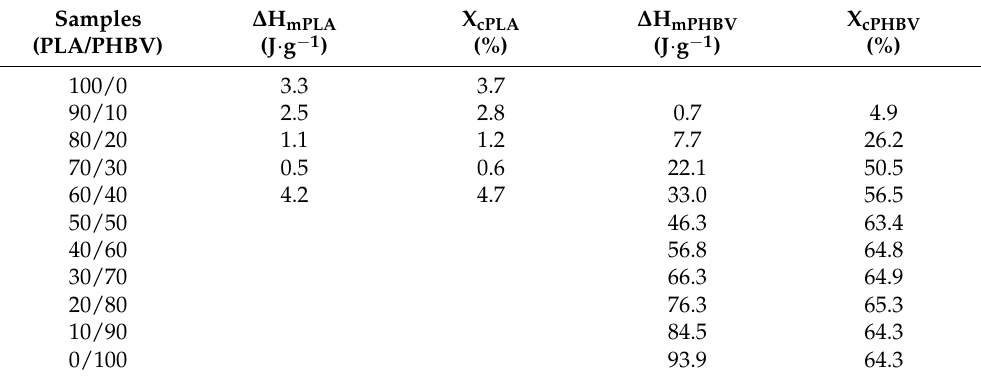
Table 6. Enthalpy and degree of crystallization of PLA and PHBV at different compositions.